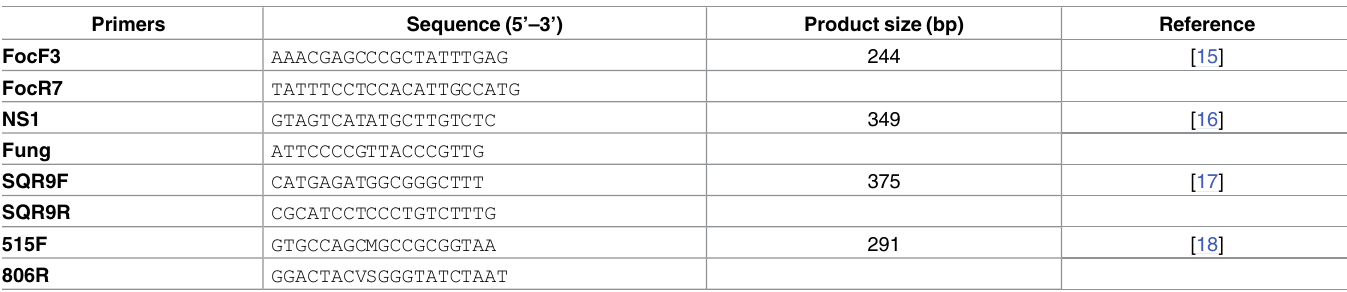
Table 2. Primers used in the real-time